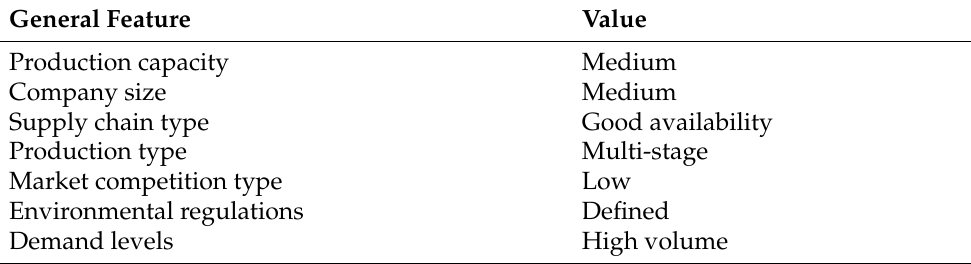
Table 2. General features of the organization for system characterization.